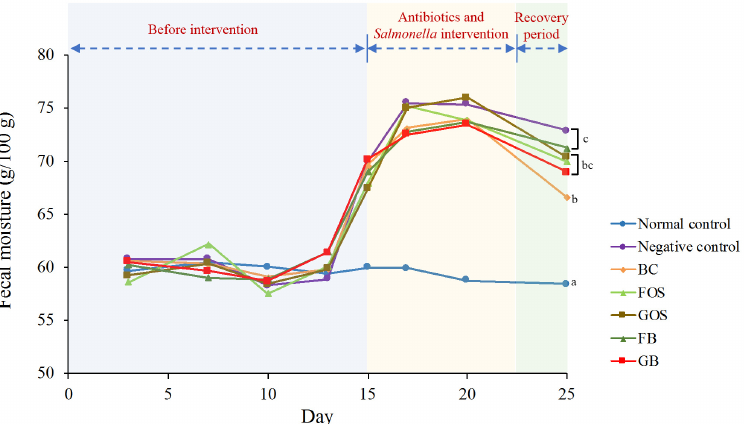
Figure 3. Change in fecal moisture among different animal groups. Blue zone (days 0 to 14) indicates the period before intervention. Yellow zone (days 15 to 22) indicates the period of antibiotics intervention and Salmonella infection. Green zone (days 23 to 25) indicates the recovery period. Mean values on the curves bearing different letters (a–c) indicate significant differences ( p < 0.05) among different groups on day 25.